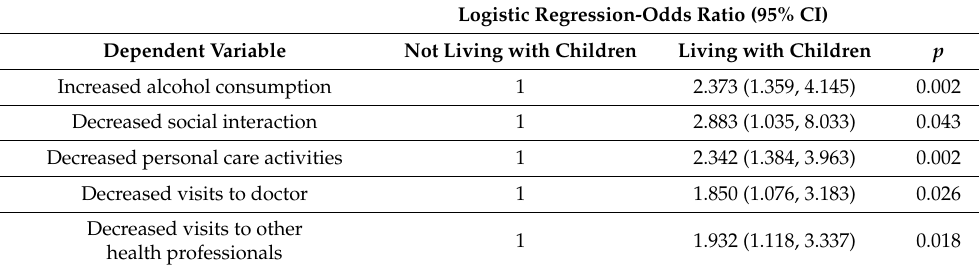
Table 3. Associations between rural females living with or without children and changes to